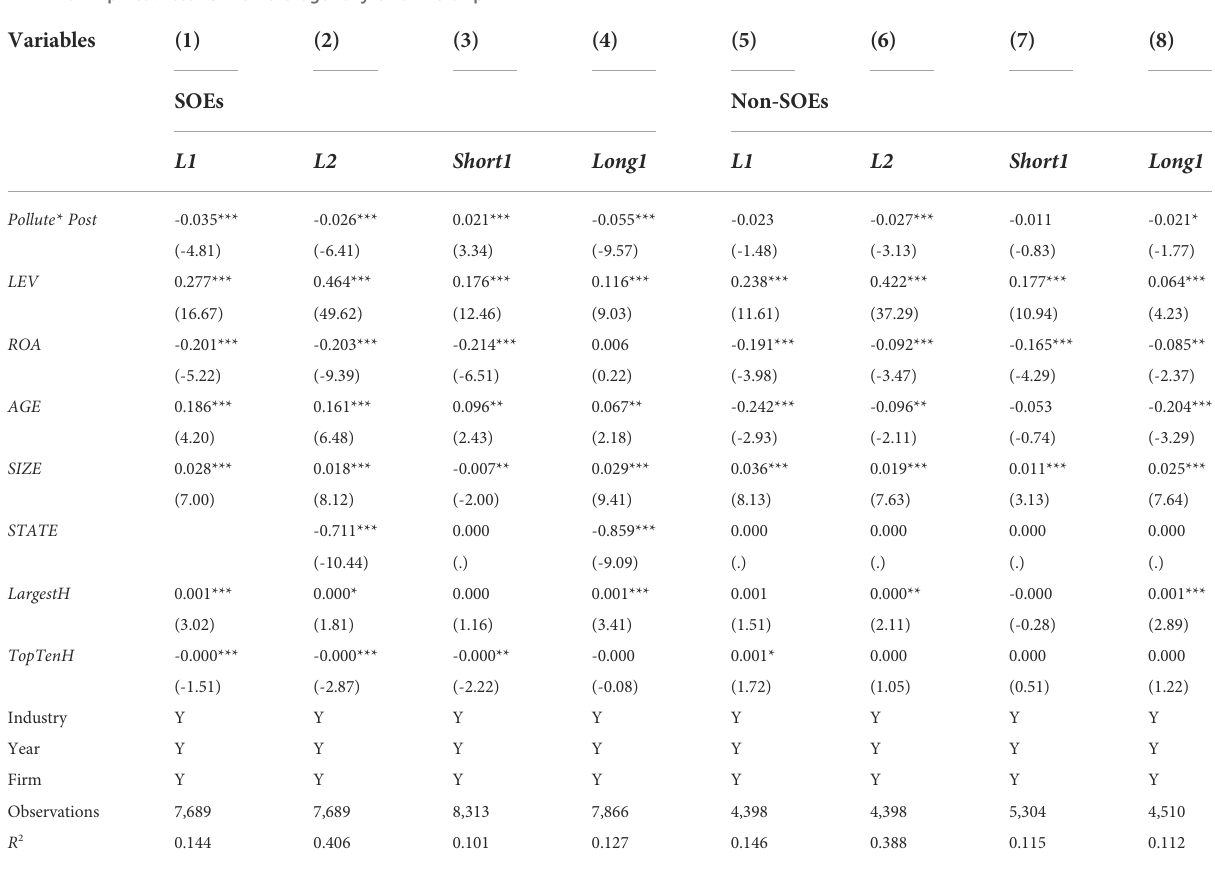
TABLE 6 Empirical results the heterogeneity of ownership.